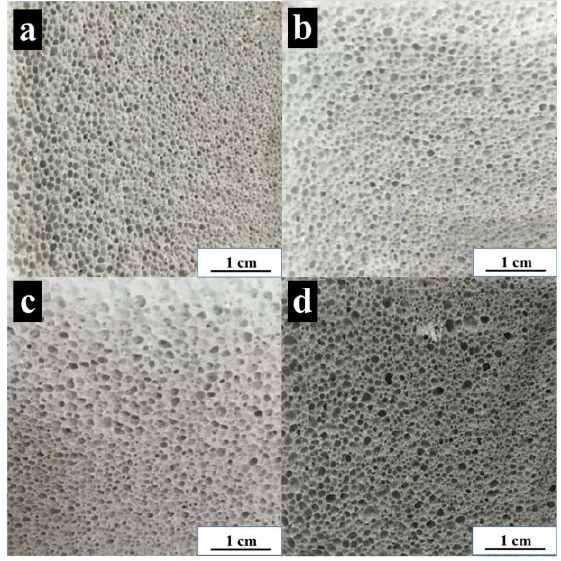
Figure 7. Sectional view of the foam ceramics with different gold tailing contents: ( a ) S1, 30%; ( b ) S2, 50%; ( c ) S3, 70%; and ( d ) S4, 77%.